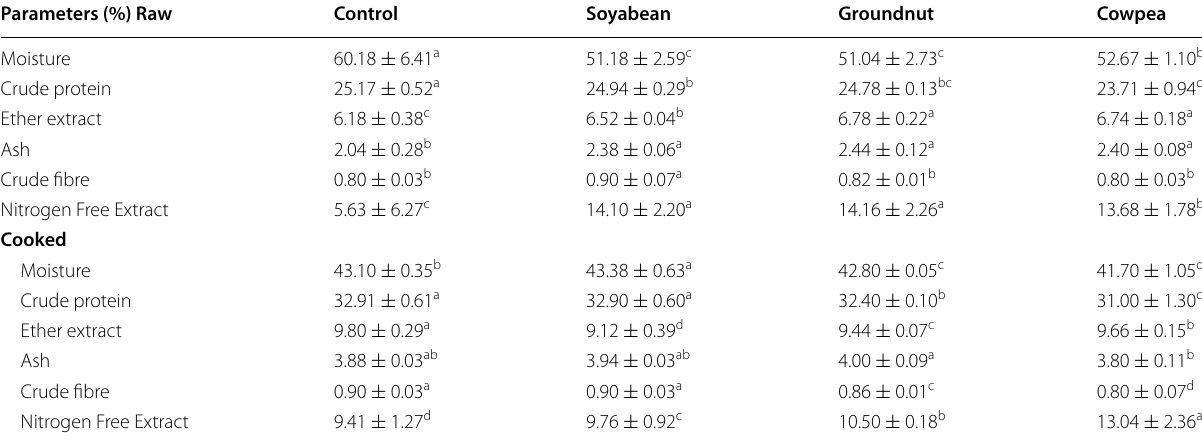
abcd Means in the same row with varying superscripts are significantly different ( P < 0.05)